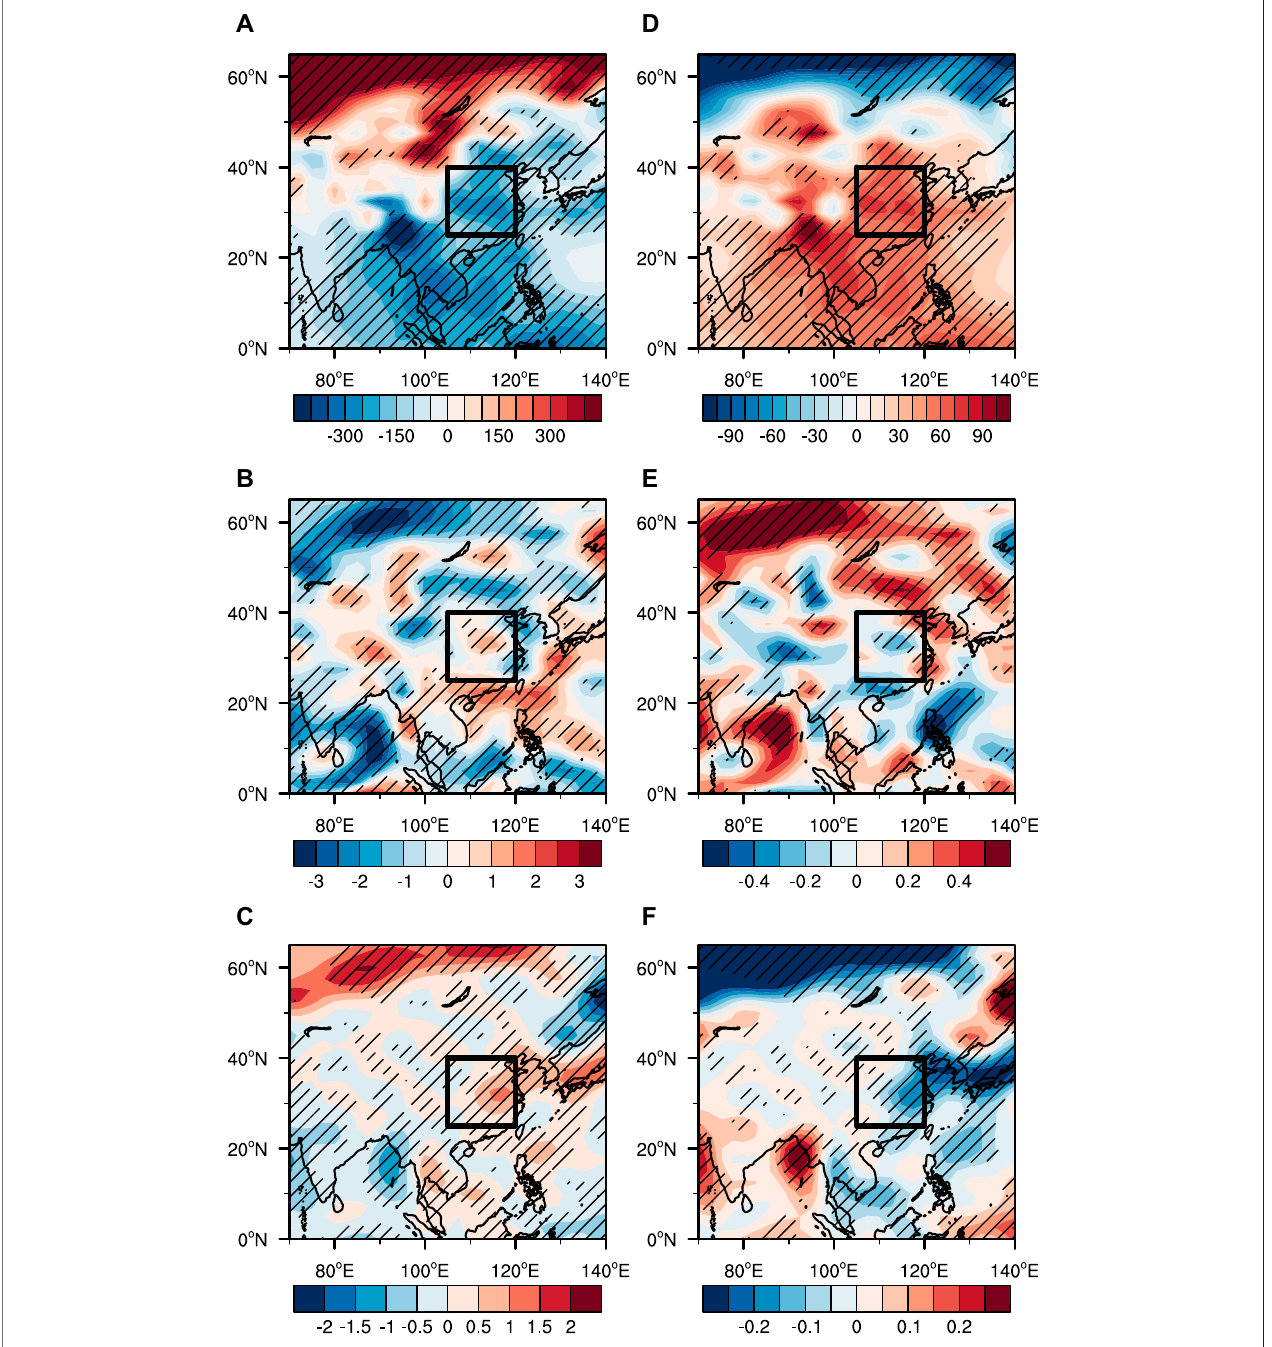
FIGURE2| Regressionof (A,D) SLP(units:Pa · K − 1 ), (B,E) windspeedat1000 hPa(units:m · s − 1 · K − 1 ), (C,F) potentialtemperaturebetween925 hPaand1000 hPa on the AMO index [left, (A – C) ] and the PDO index [right, (D – F) ] in winter from 1979 to 2018. The crosses indicate values exceeding the 95% con fi dence level. The outlined area is central and East China.